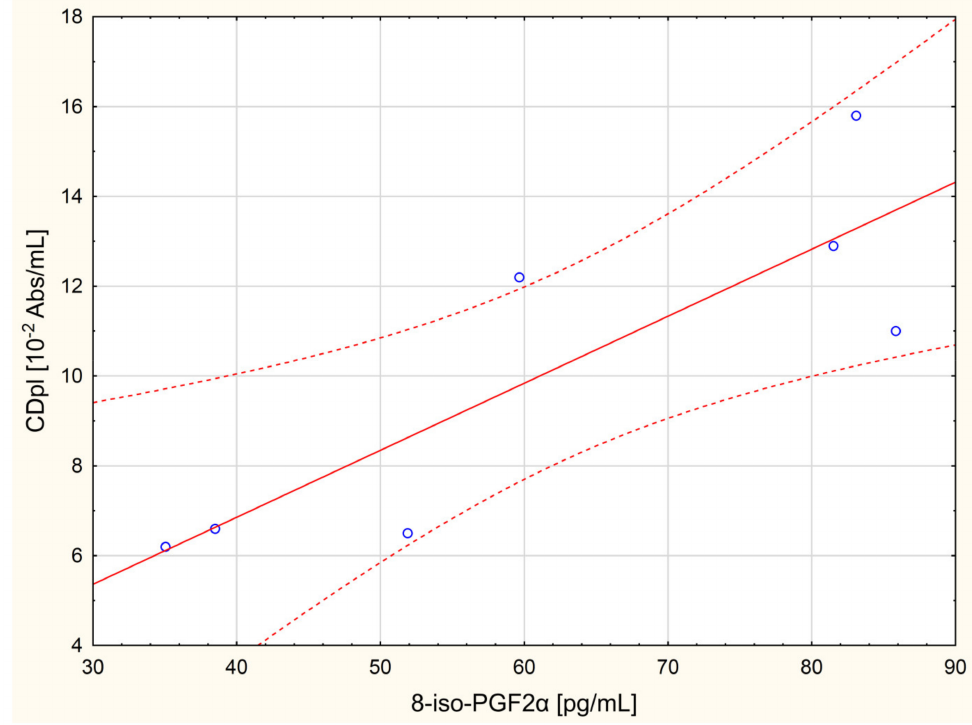
Figure 2. Pearson’s correlation between the serum concentration of 8-iso-prostaglandin F2 α and the plasma concentration of conjugated dienes in women with ovarian cancer ( r = 0.97, p =